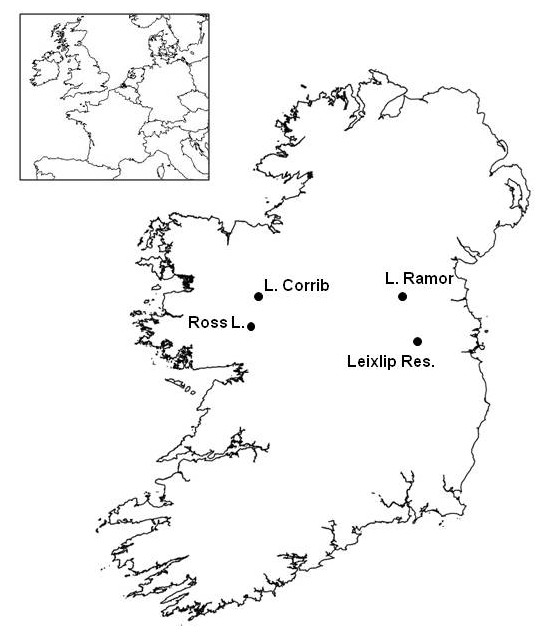
Geometric morphology and genetics of roach bream and roach × bream hybrids in L. Ramor and Ross L. Combined relative warp and molecular analyses performed on specimens collected in L. Ramor (A) and Ross L. (B). Splines reflect the shape deformation along RW1. Fish morphometrically assigned as bream, roach and hybrids are represented as circles, diamonds and triangles respectively. Specimens confirmed as homozygous bream or roach by genetic analysis are coloured in red and green while heterozygous hybrids are blue. Putative back-crosses hybrids which were unassigned by the DFA analysis are highlighted by arrows.